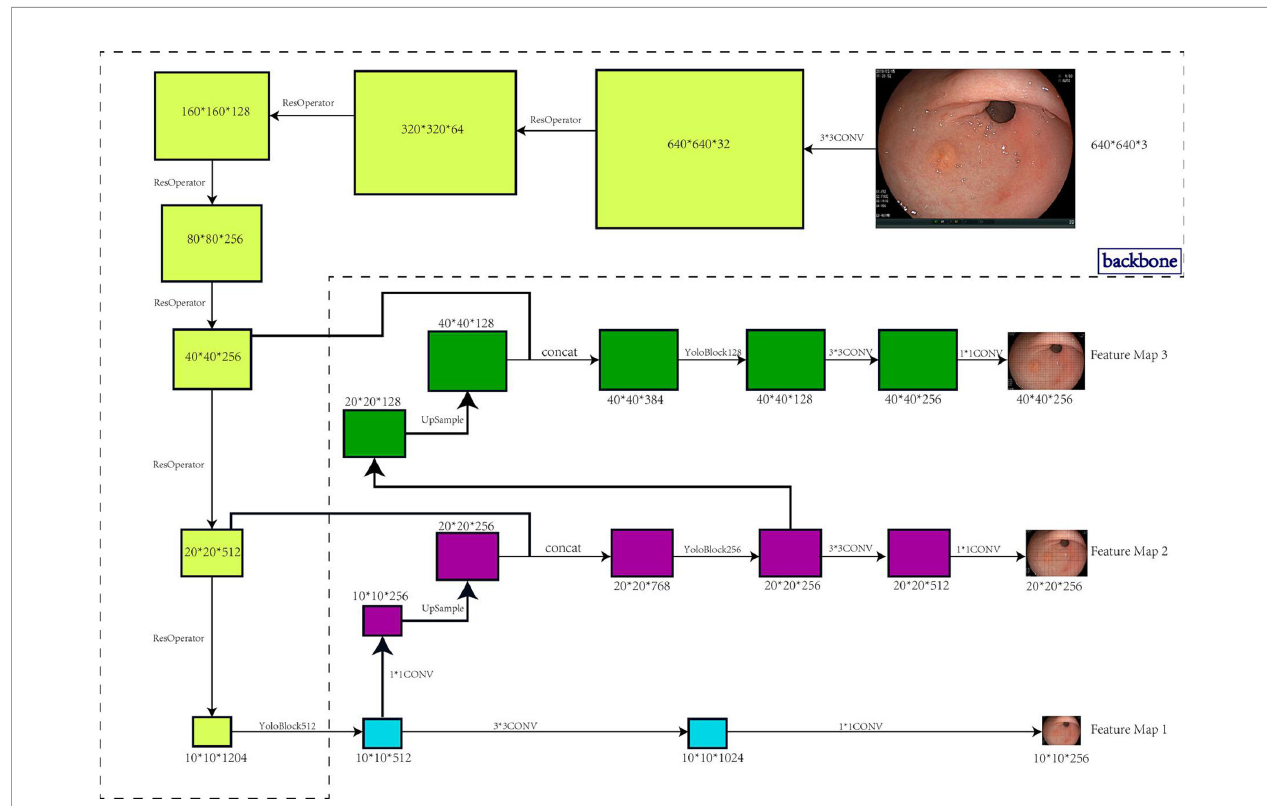
FIGURE 1 | Architecture and work fl ow of the EGC-YOLO system. The target detection model was divided into three parts, the backbone, the bottleneck network, and the detection head. The backbone network was responsible for the feature extraction of the image. 640x640x3 image raw input was transformed into 40x40x256 feature maps using 5 Resnet cell operations. The neck network was the feature fusion layer that used a three-layer spatial pyramid to fuse information with a large receptive fi eld to a network with a small receptive fi eld. In particular, the 40x40x256 input was transformed into 20x20x512 and 10x10x1024 using two Resnet unit operations, then 10x10x1024 was up-sampled to 20x20x256 using two layers of networks, and 20x20x512 features were stitched into 20x20x768 using another layer of networks. Similarly, the 40x40x256 was also fused to the 20x20x256 features into 40x40x128. The detection head used the three spatial pyramid features exported by the neck network to output the fi nal target